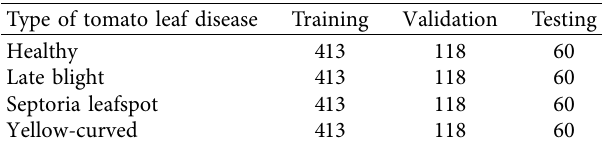
Table 1: Distribution of the laboratory-based dataset for training, validation, and